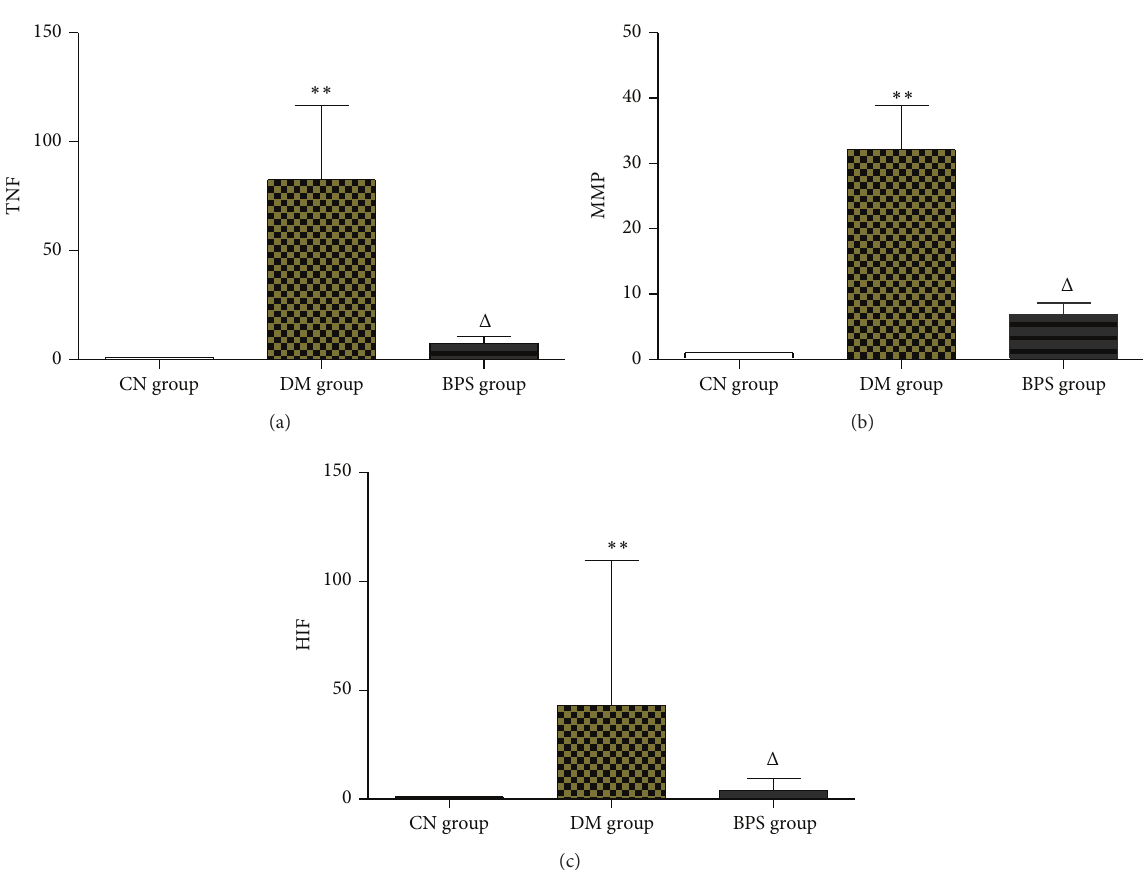
Figure 7: RT-PCR results of inflammatory factors. Compared with the CN group, the mRNA for TNF- 𝛼 , MMP-9, and HIF-1 𝛼 in the myocardial tissues of rats significantly increased in the DM group ( 𝑃 < 0.01 ) and also increased in the BPS group ( 𝑃 > 0.05 ). Compared with the DM group, the levels of TNF- 𝛼 , MMP-9, and HIF-1 𝛼 mRNA in rats of the BPS group significantly decreased ( 𝑃 < 0.01 ) and were similar to the levels or rats in the CN group ( 𝑃 > 0.05